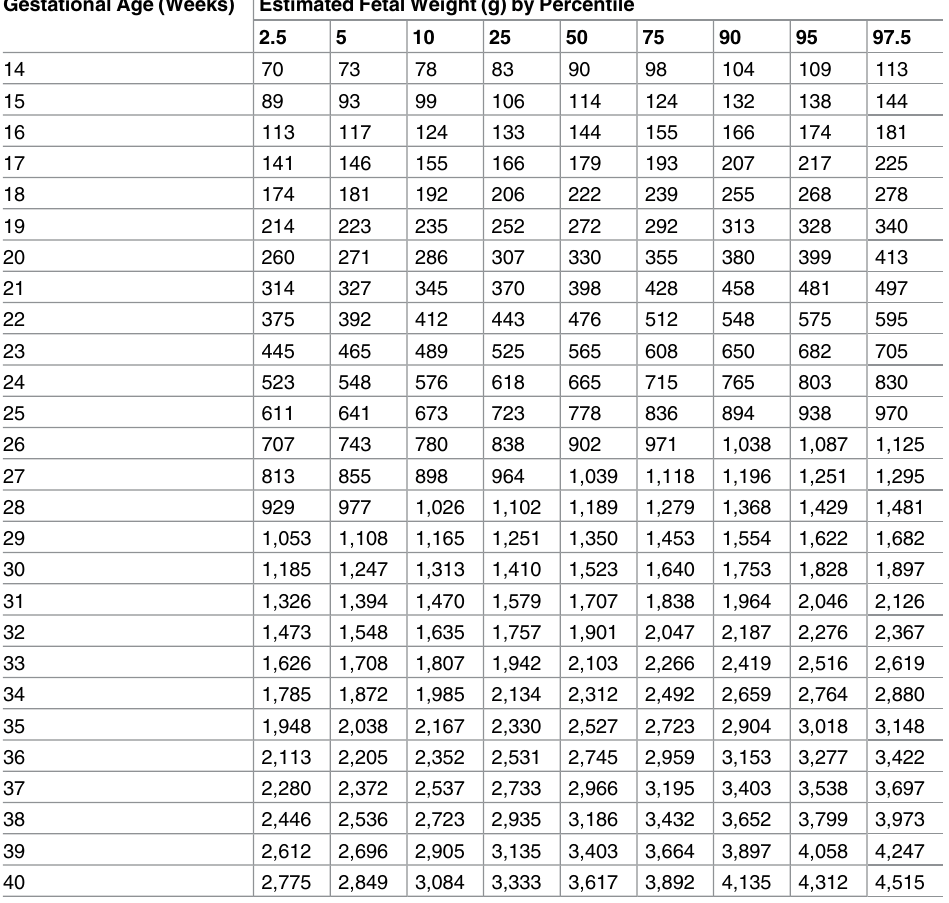
Table 11. Growth chart for estimated fetal weight regardless of fetal